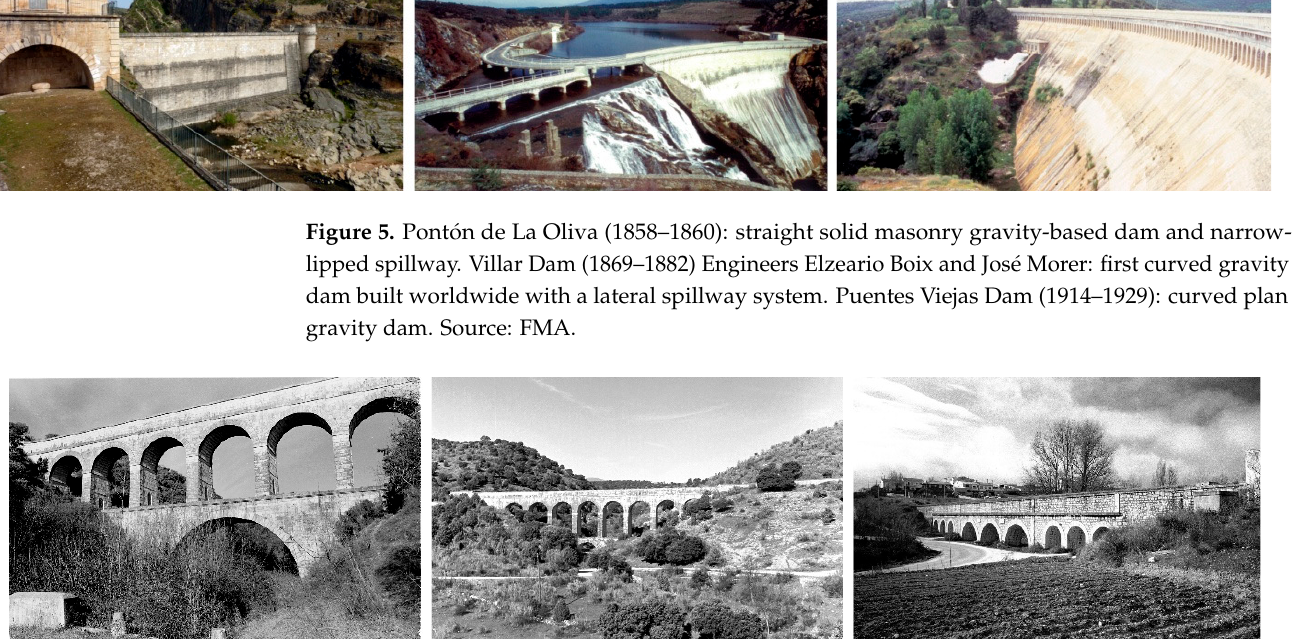
Figure 6. Canal Bajo Aqueducts: La Sima Aqueduct (1855), La Retuerta Aqueduct (1855) and El Es- partal Aqueduct (1852). Source: FMA.